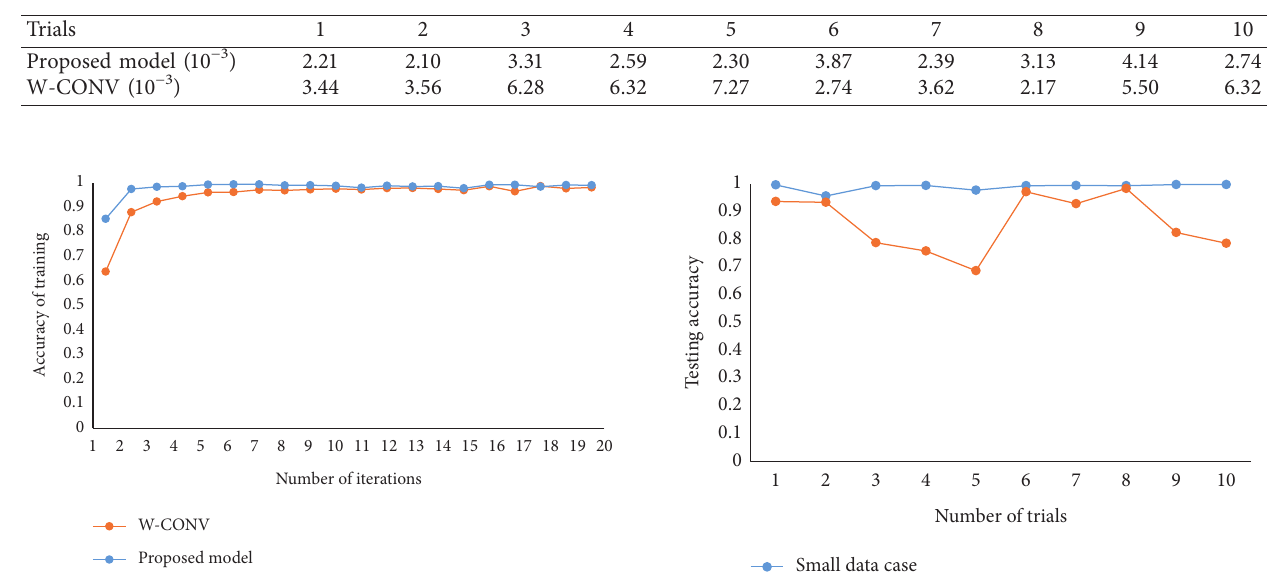
Table 7: Comparison of two models using RMSLE of 10 trials.